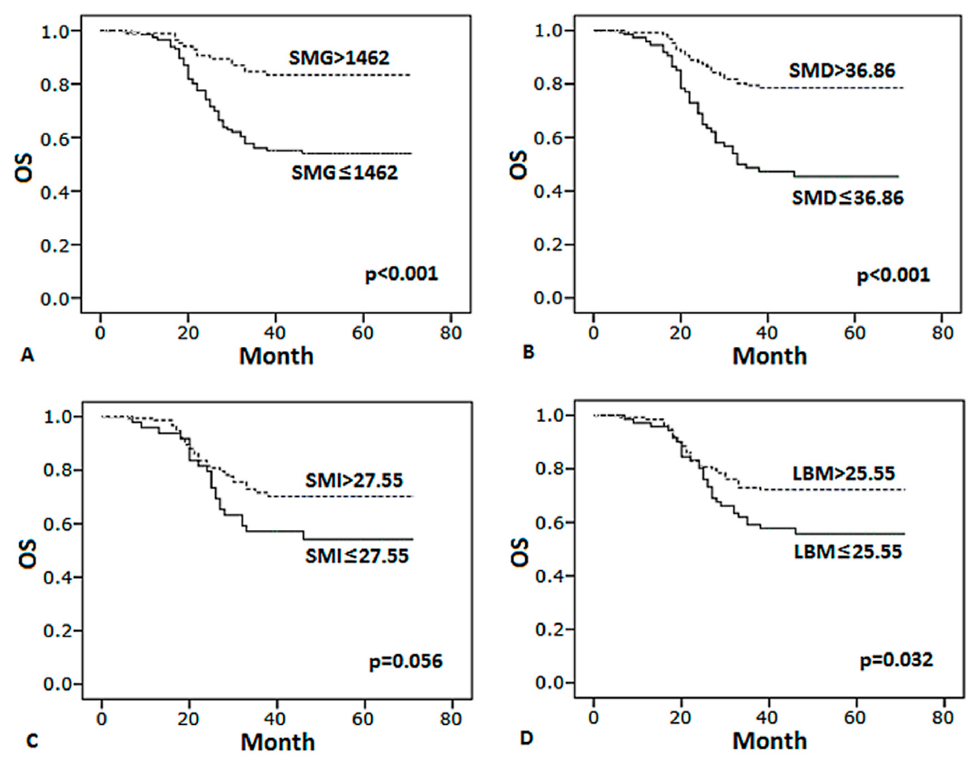
Figure 3. Kaplan–Meier curves of PFS for patients by body composition. ( A ) SMG (skeletal muscle gauge), ( B ) SMD (skeletal muscle density), ( C ) SMI (skeletal muscle index), ( D ) LBM (lean body mass).